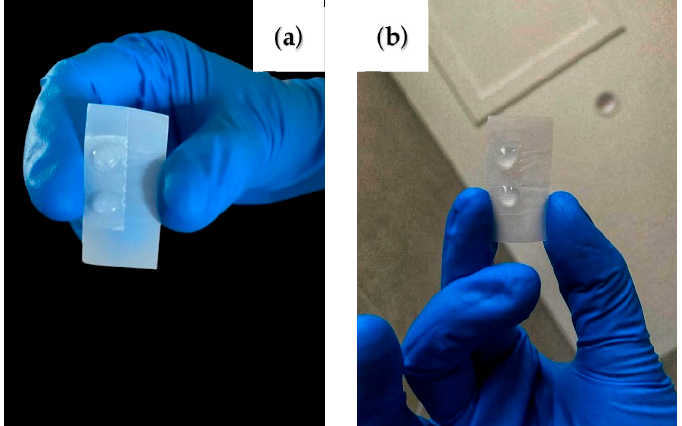
Figure 4. Digital image demonstrating the ‘petal effect’ displayed by the sample when the sample is titled at ( a ) 90° and ( b ) 180°.